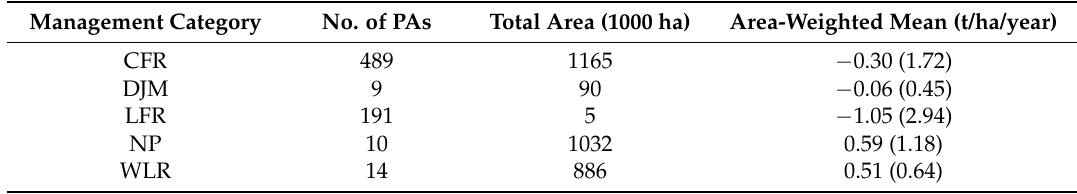
Table 1. Summary of PA characteristics: number of PAs, total PA size, area-weighted mean carbon loss or gain. Numbers in parenthesis with area-weighted mean are standard